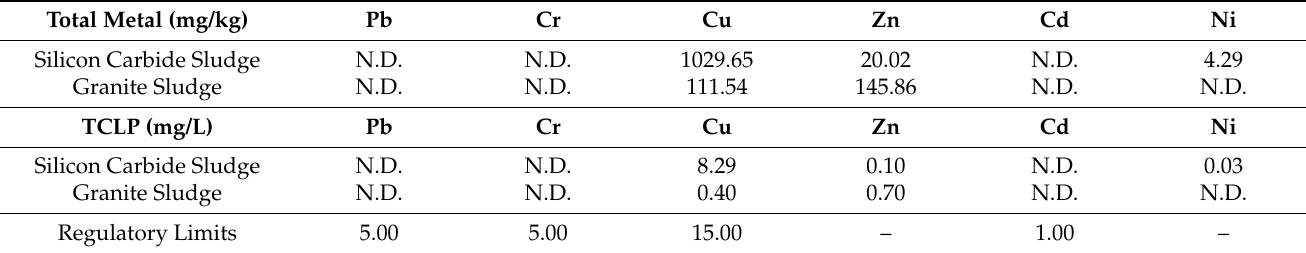
Table 3. The total metals and TCLP leaching concentration of raw